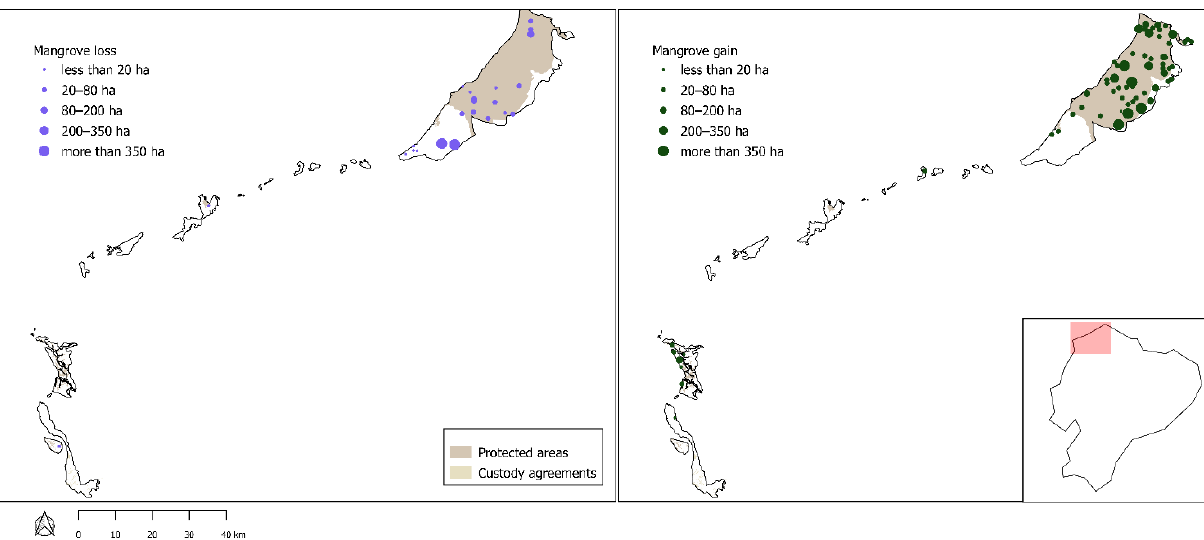
Figure 8. Mangrove losses and gains in the Manabí province between 1998 and 2016.